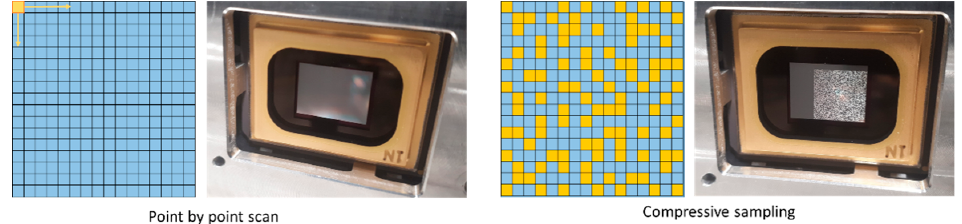
Figure 2. Schematics of the two different sampling modes used, and photos of how each is implemented on the digital micromirror device (DMD): on the left, point-by-point sampling; on the right, compressive sampling.